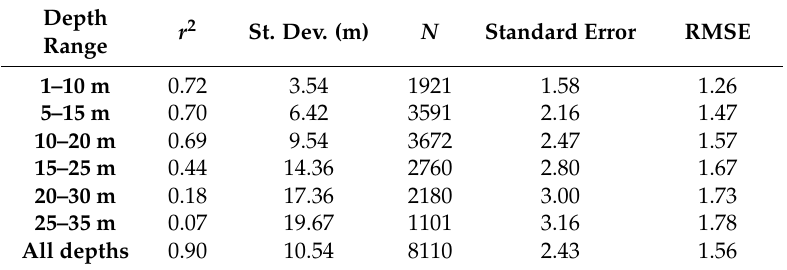
Figure 9. Linearized (Ln) Relationship between values of the WV2 Depth Model and the LiDAR SHOALS depth (meters). Table 2. A coefficient of determination ( r 2 ), standard error, standard deviation and the Root Mean Square Error (RMSE) for six depth ranges for the WV2 depth model for validation. WV2 Depth Model vs. LiDAR SHOALS.